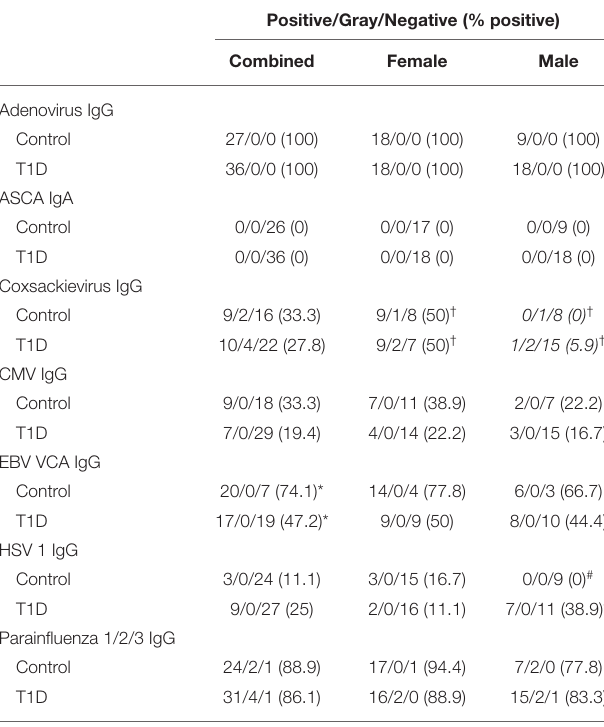
TABLE 3 | Qualitative anti-pathogen antibody